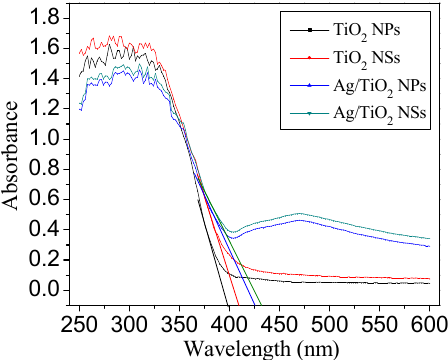
Figure 7. UV–vis DRS spectra of different Figure 7. UV – vis DRS spectra of different catalysts. Figure 7. UV – vis DRS spectra of different catalysts.